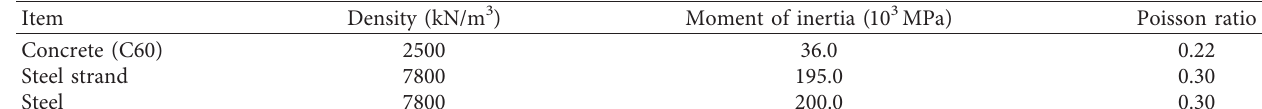
Table 4: Properties of the materials.